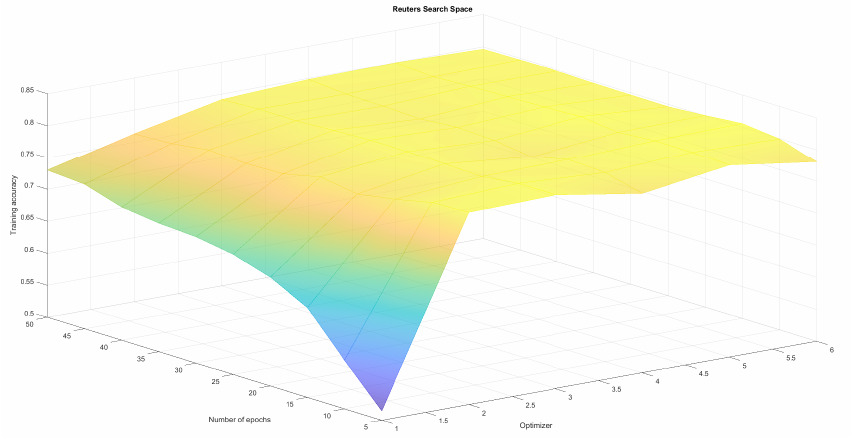
Figure 7. Epoch and optimizer search space for Reuters classification. We cannot observe one clear maximum, but for certain optimizers the performance